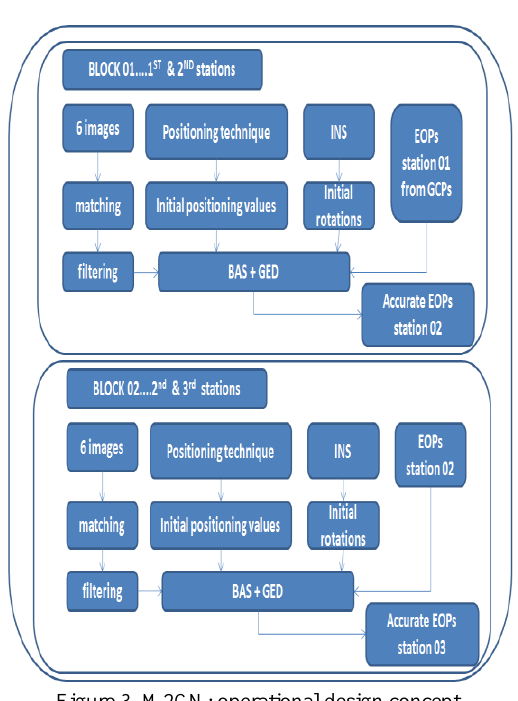
Figure 3. M2CN: operational design concept